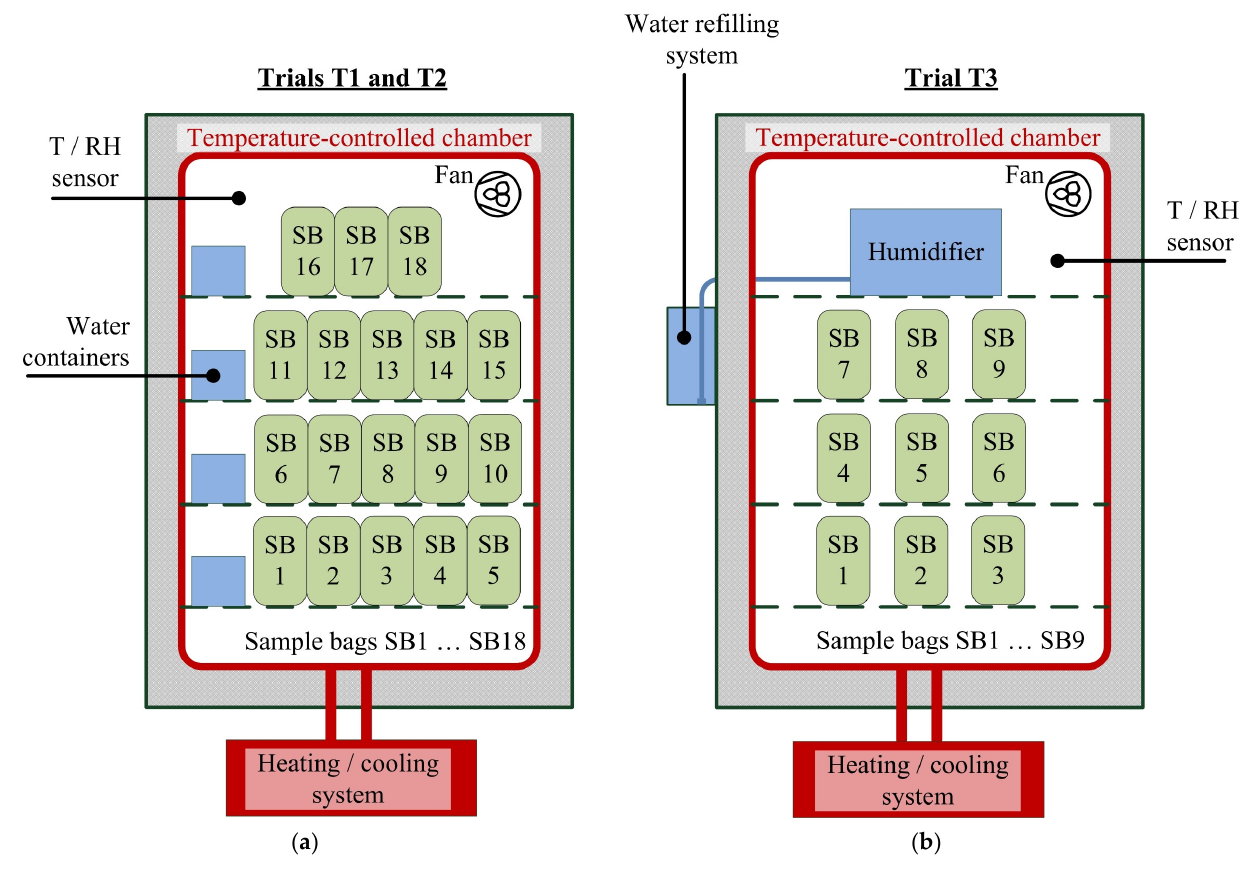
Figure 2. Storage of sample bags in a chamber under controlled temperature and assisted humidity. ( a ) Set-up used in trials T1 and T2 with water containers placed in the chamber, and ( b ) set-up using a humidifier in trial T3. T: temperature; RH: relative humidity; SB: sample bag.